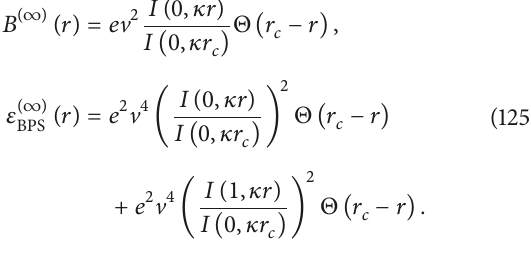
The magnetic field and BPS energy density of